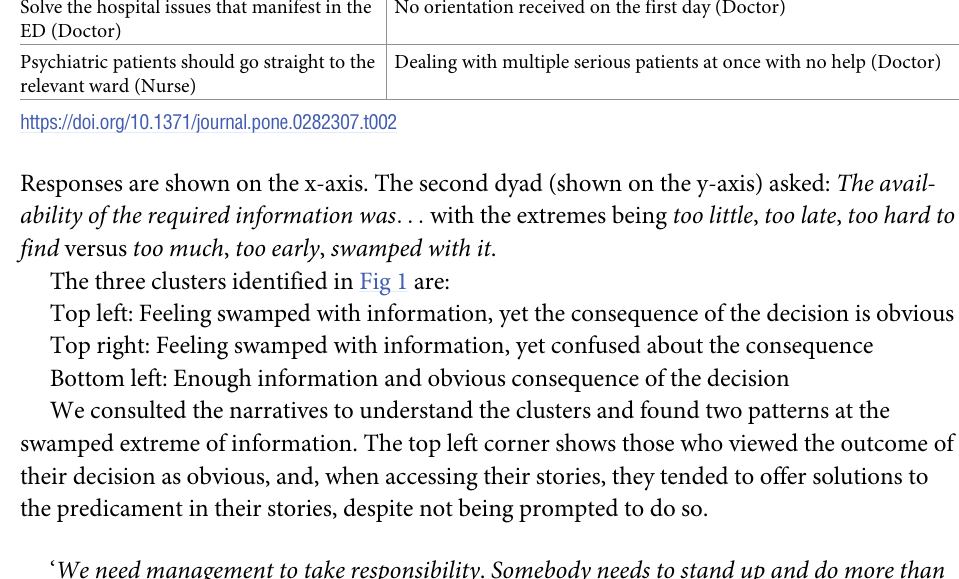
Table 2. Stories told at each extreme on the clarity of the consequence of the decision. Blindingly obvious Confusion and